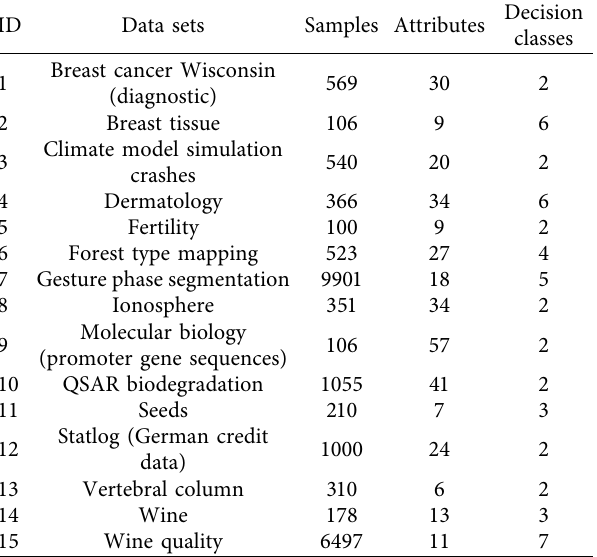
Table 2: Descriptions of data